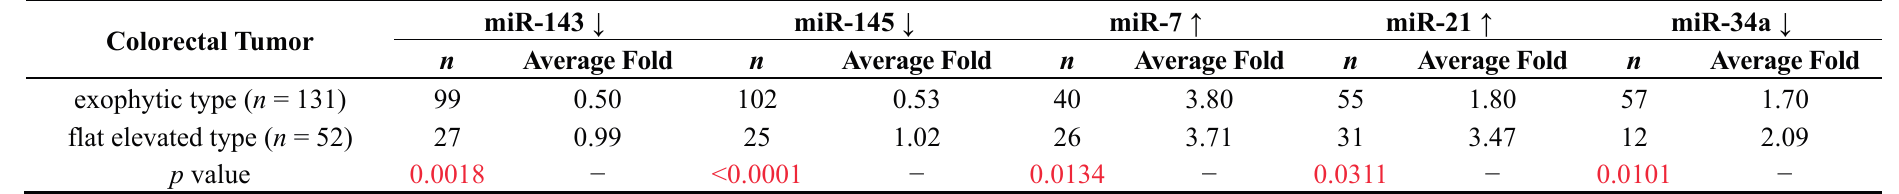
Table 4. Expression of miR-143, -145, -7, -34a, and -21 in human colorectal adenoma and early cancer tissues (exophytic and flat elevated types). Colorectal Tumor exophytic type ( n = 131)